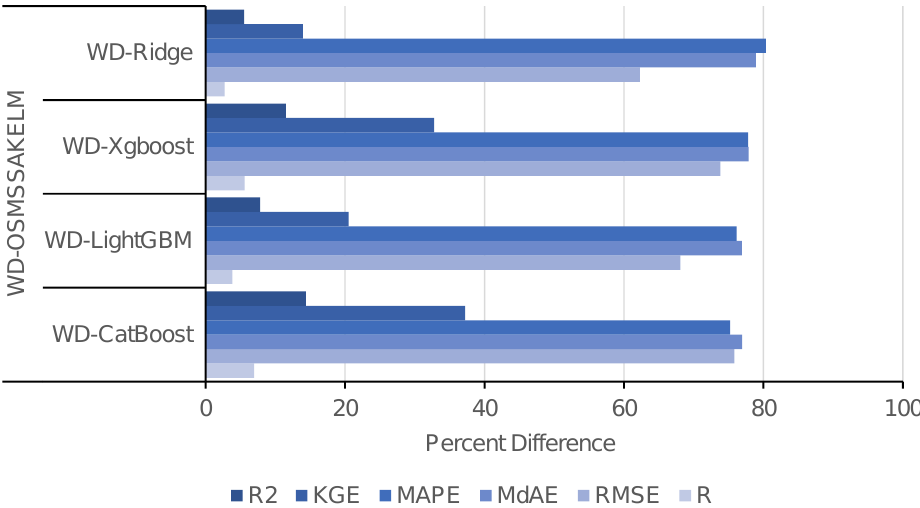
Figure 18. Percent (%) of improvement of the WD-OSMSSAKELM versus the values of other methods for the metrics during the testing